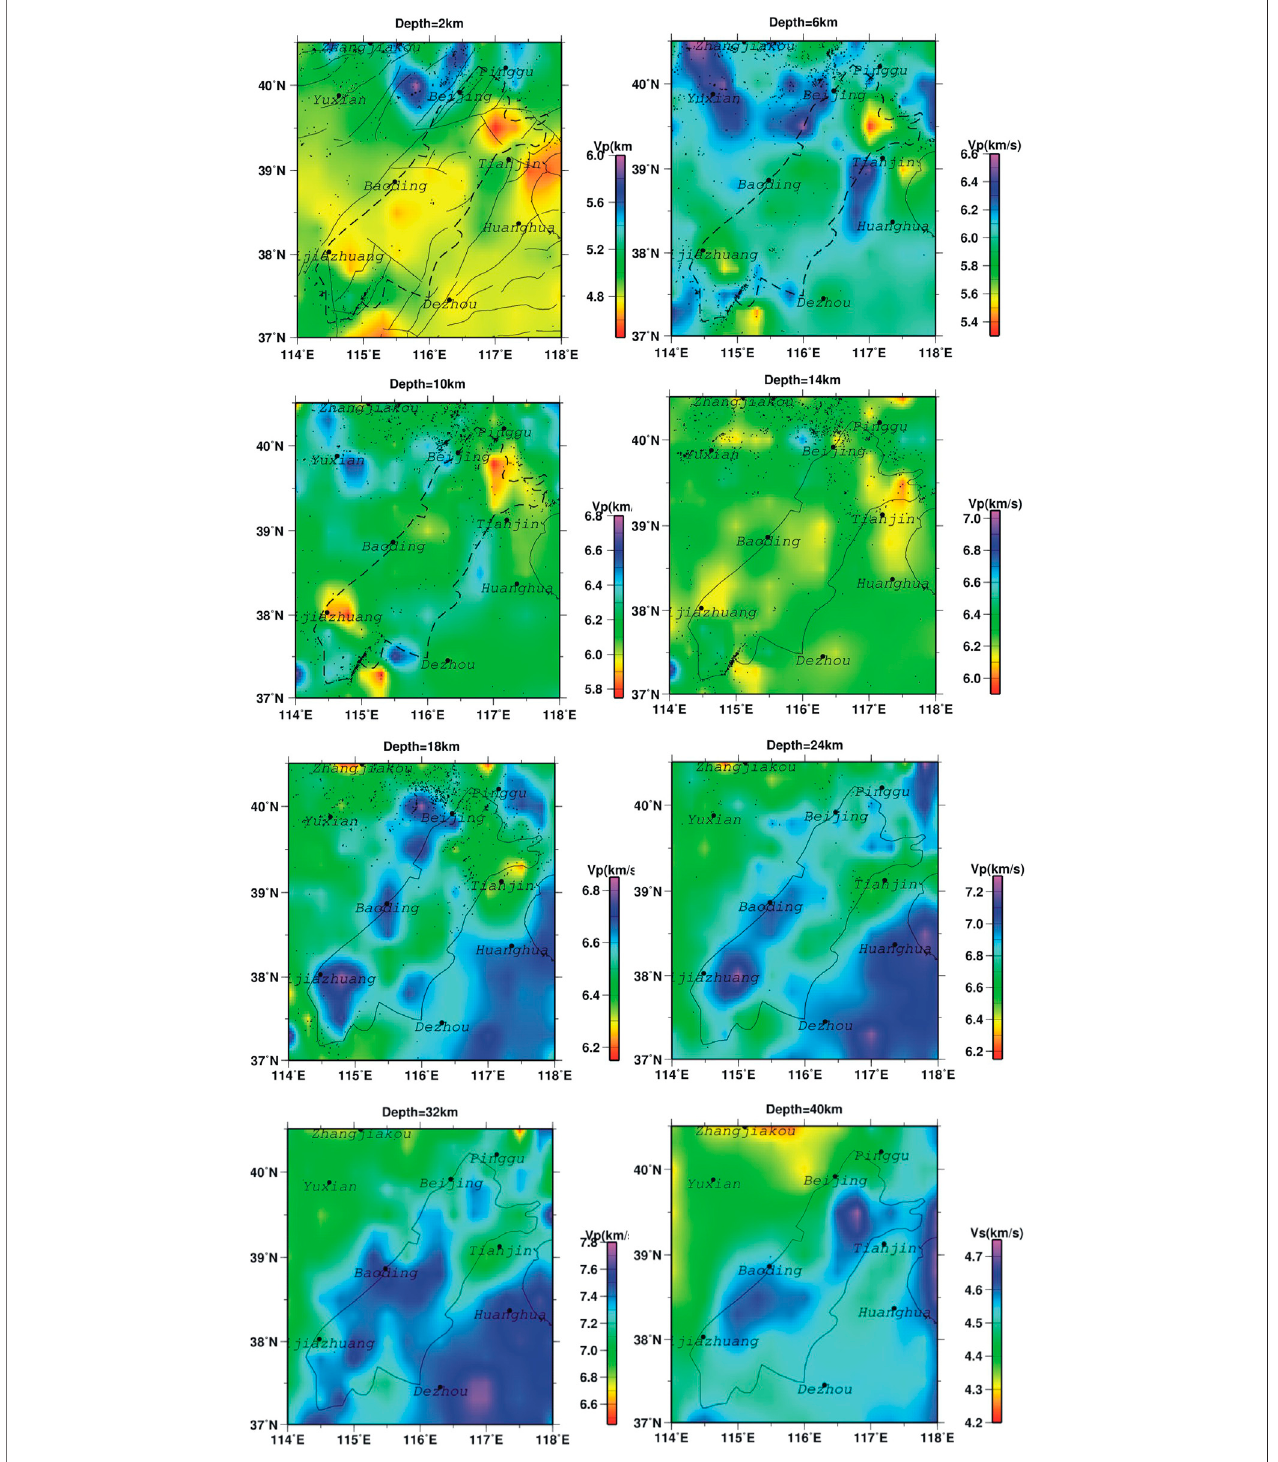
FIGURE 4 | P-wave velocity imaging at different depths in the Jizhong depression and its surroundings.